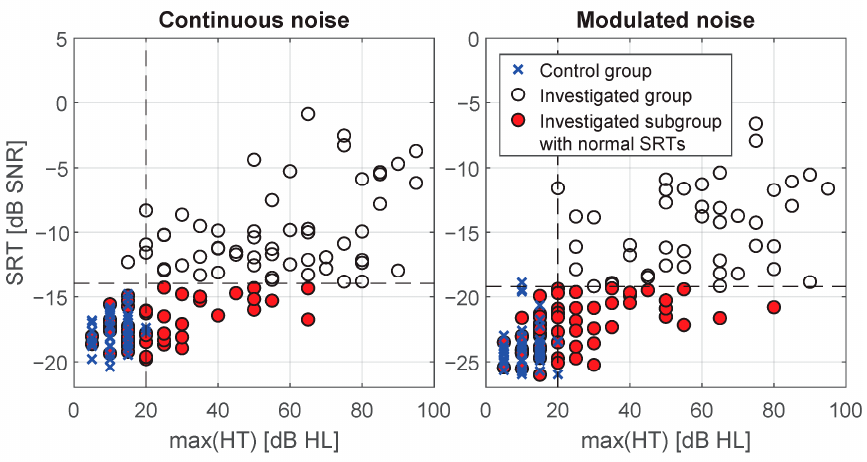
Figure 6. Selection of the investigated subgroup having speech recognition thresholds (SRTs) within normal range. Vertical dashed line—eligibility criteria for the control group; horizontal dashed line—cut-off threshold of normal SRTs; max(HT)—maximal air conduction threshold in the frequency range 0.25–8 kHz.